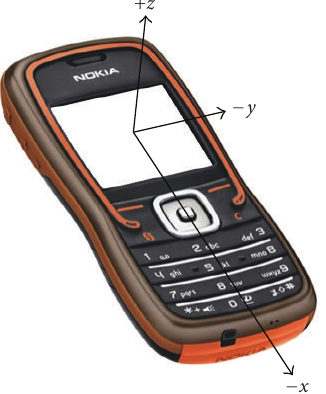
Figure 2: Nokia 5500 accelerometer axes.